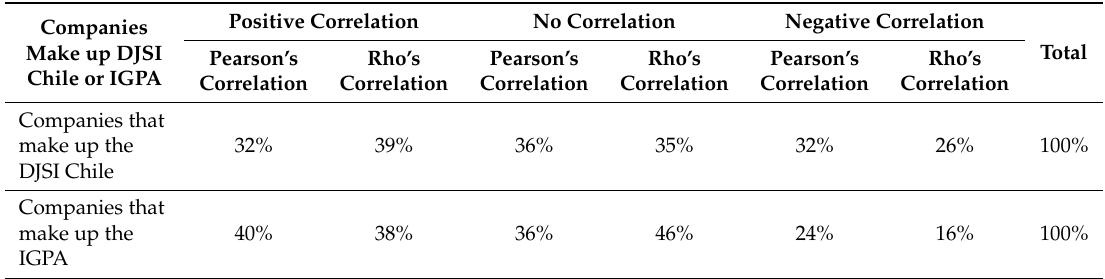
Table 3. Summary of ROA correlations with the DJSI Chile.